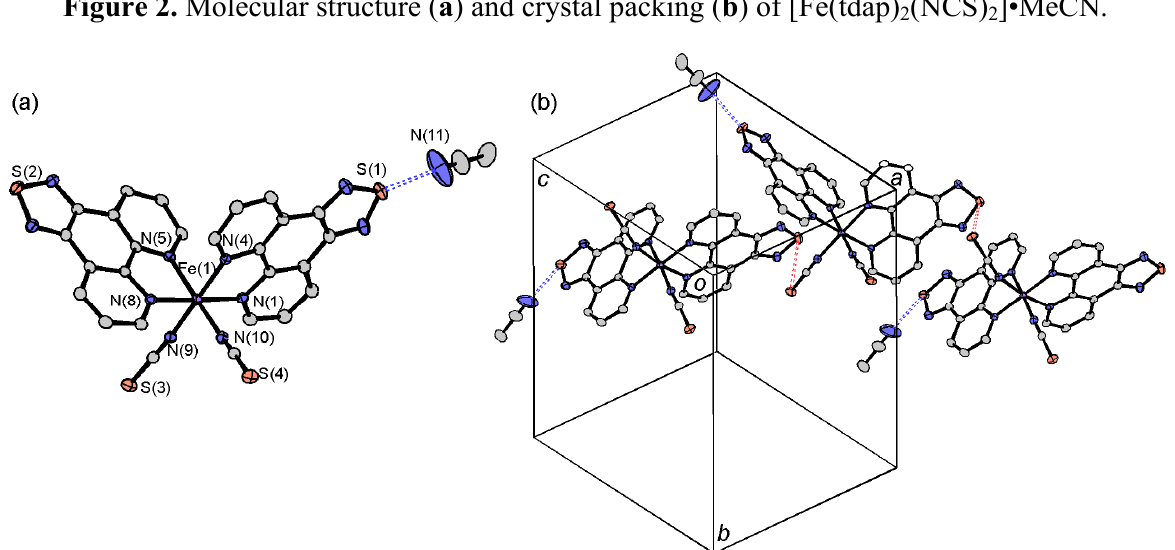
Figure 2. Molecular structure ( a ) and crystal packing ( b ) of [Fe(tdap)